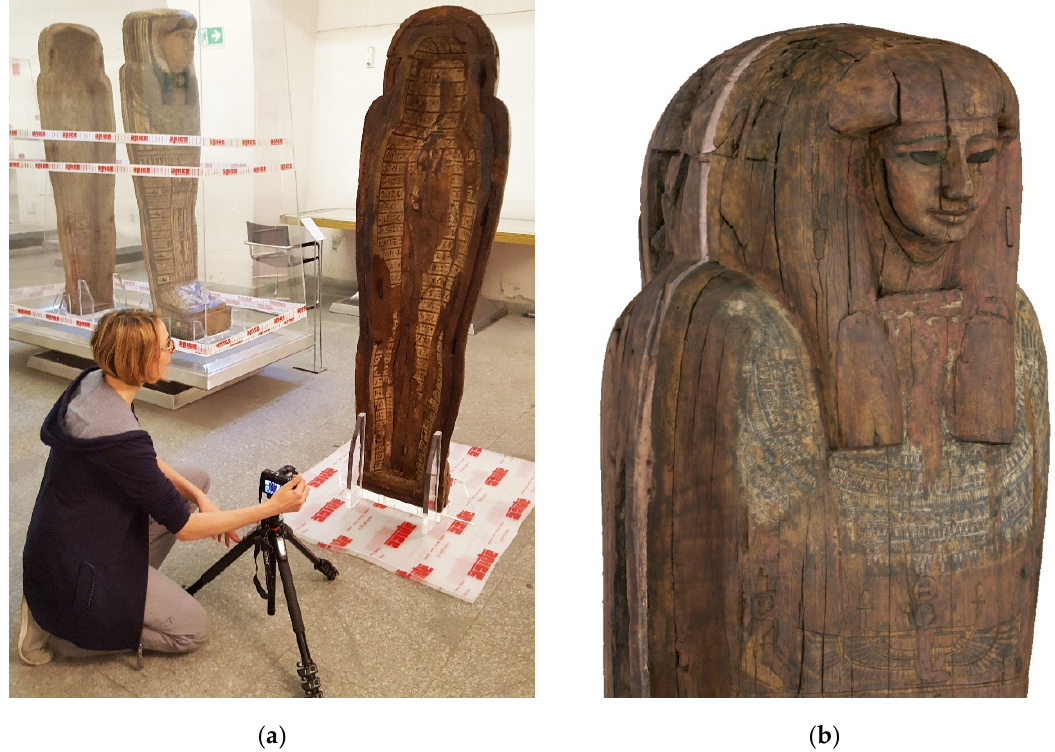
Figure 1. Anthropomorphic coffin of Peftjauauiaset: ( a ) photographic survey of the posterior valve for reconstruction using the SFM/IM (structure from motion/image matching) system, carried out at the Civic Archaeological Museum of Milan during the dismantling of the exhibition area for modernization works; ( b ) detail of the 3D model with a high-resolution texture of the two valves together.